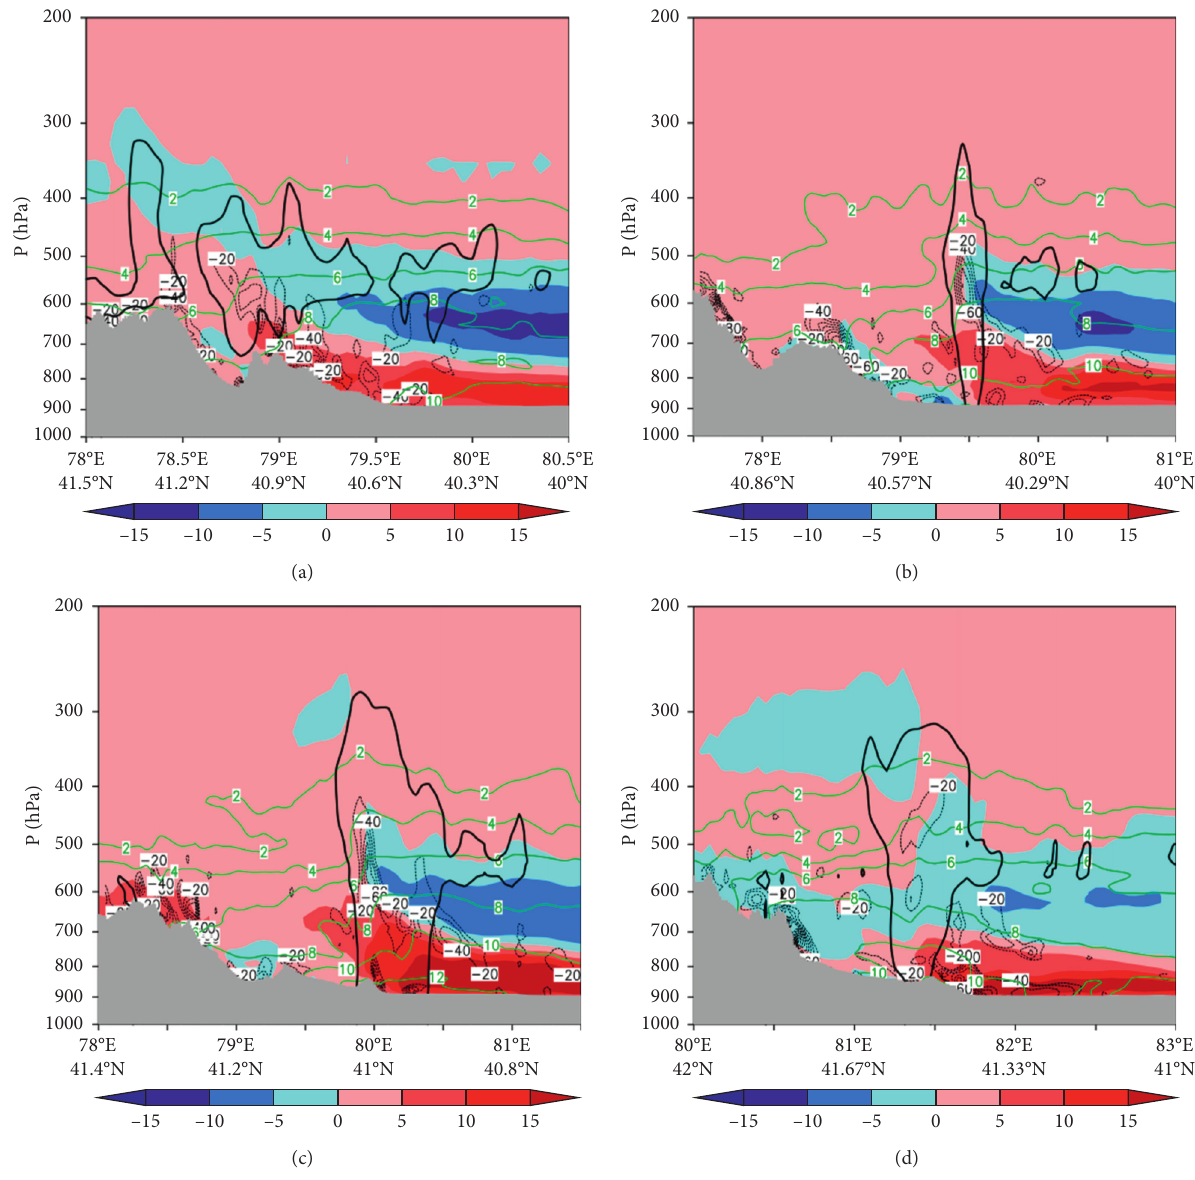
Figure 9: Vertical cross sections of simulated water vapor flux (shaded, unit: g · cm − 1 · hPa − 1 · s − 1 ; the positive value mean transport from the Tianshan Mountains to Aksu and the negative value mean transport from Aksu to the Tianshan Mountains), divergence of water vapor flux Figure 5. (a) Initiation stage at 12:00 on July 31. (b) Development stage at 16:00 on July 31. (c) Maturity stage at 17:30 on July 31. (d) Extinction stage at 22:00 on July 31,